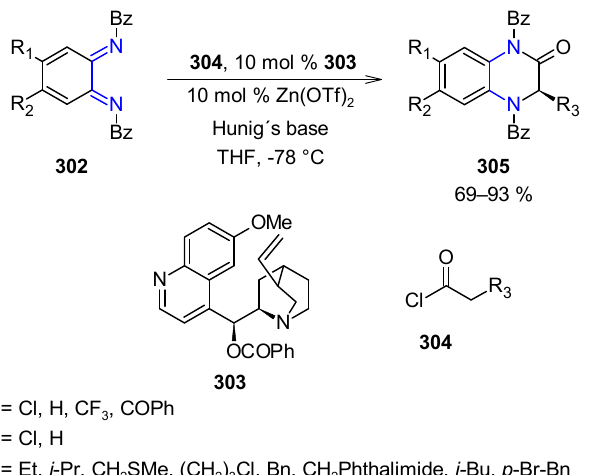
Scheme 73 . Synthesis of dihydroxyquinoxaline derivative 305 by hetero ‐ Diels–Alder reaction of ke ‐ tene enolates and ortho ‐ benzoquinone diimides 302